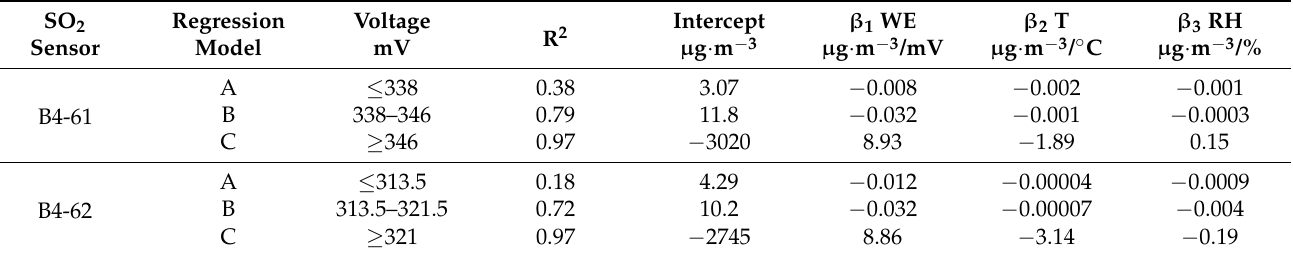
Table 5. Regression coefficients of the MLR applied to different segments of data (voltage) generated by the SO 2 sensors.